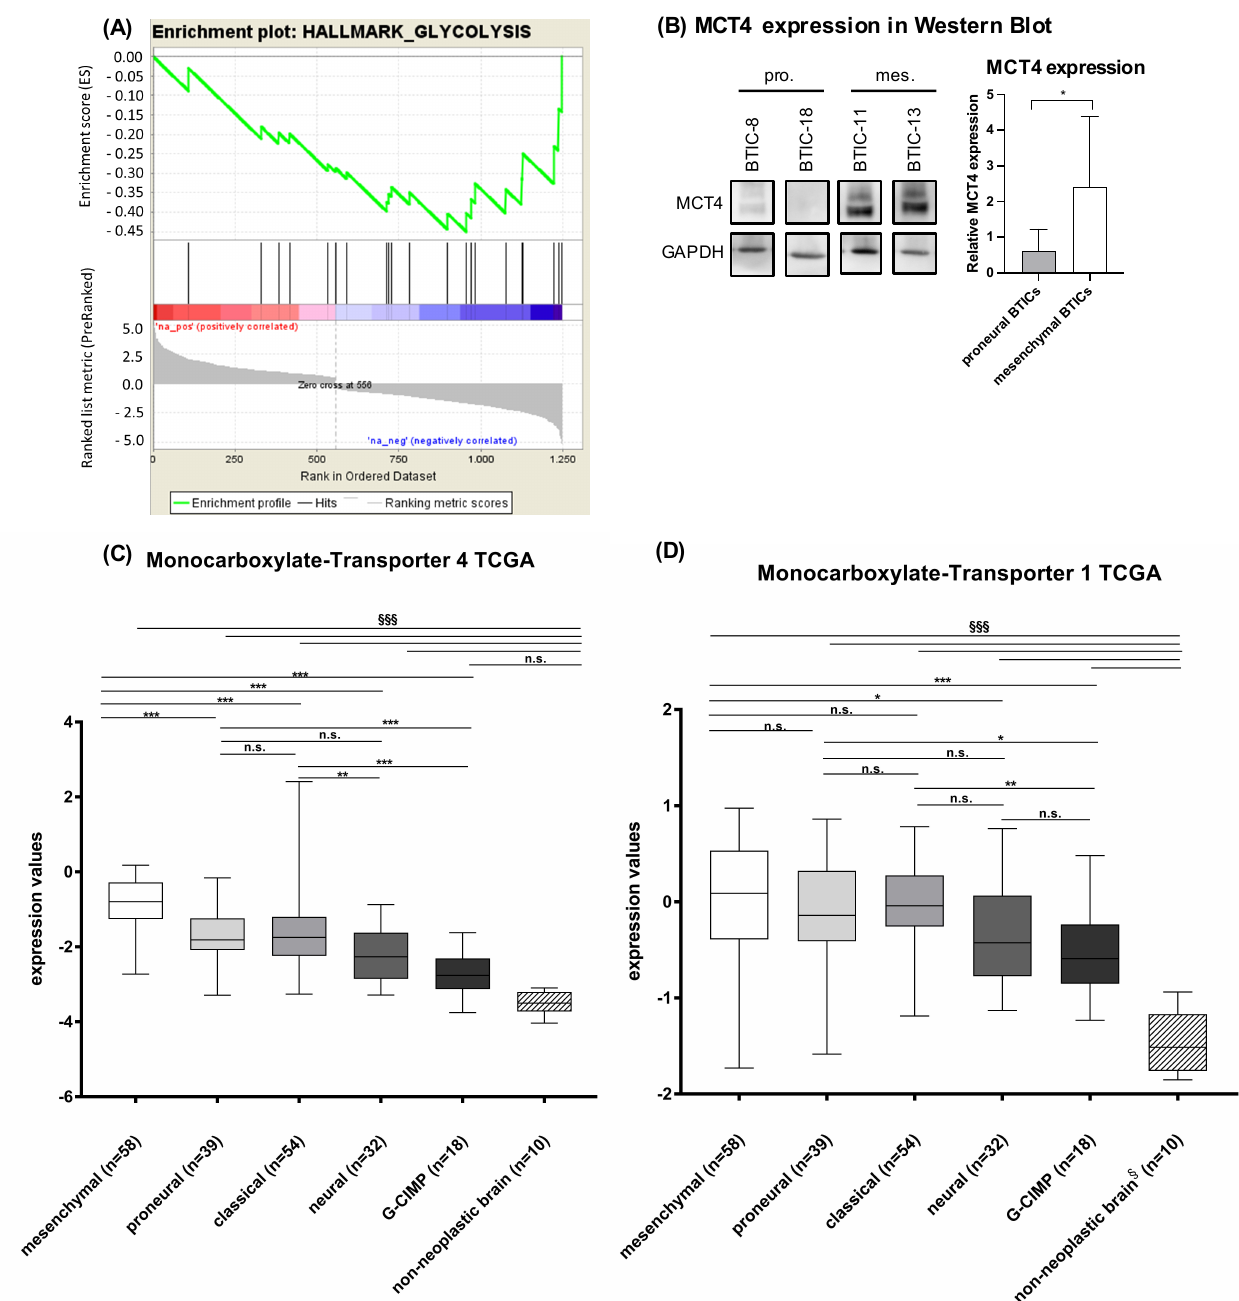
Figure 5. Hallmark analysis of mRNA-microarrays. ( A ) The enrichment plot indicates increased expression of glycolytic genes in mesenchymal BTICs (based on 36 lines including those used for this study). ( B ). We verified mRNA-microarray results using Western blot. Thereby, an increased protein expression of MCT4 could be confirmed, which is shown in the exemplary blot. Western blots were repeated three times with at least two biological replicates and quantified using Image J. Array and expression results were validated using TCGA-data for ( C ) MCT4 and ( D ) MCT1 . All assays were performed in triplicate. Asterisks indicate * p < 0.05, ** p < 0.01, *** p < 0.001, §§§ indicate p < 0.001 for comparison with non-neoplastic brain, n.s. = not